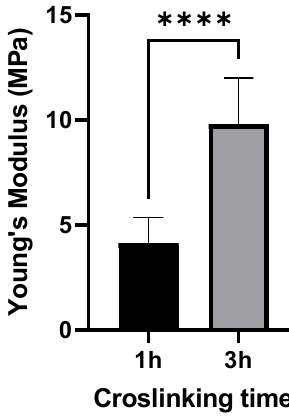
Figure 3. Young’s moduli for 150 kDa FITC-dextran-loaded GNPs produced with the two different crosslinking times applied in this study. Data is presented as the mean ± SD of three independently prepared batches, **** 3 h crosslinked particles are significantly different from 1 h crosslinked GNPs ( p < 0.001).